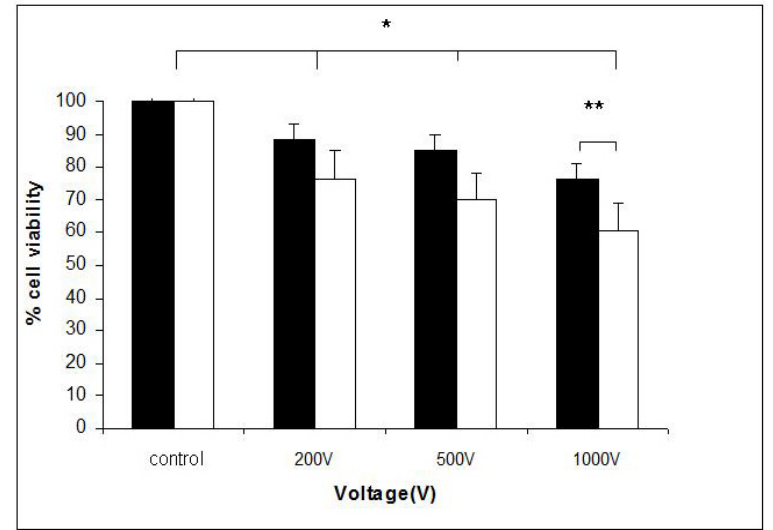
Figure 1. Viability of HaCaT keratinocytes after treatment with high voltage electric pulses alone (black columns) or in combination with rifampicin (white columns). Bars—SD (Standard Deviation); * p < 0.05 versus control groups; ** p < 0.01, significant difference between electroporated cells in the absence of rifampicin and electroporated cells in the presence of 20 μ g·mL − 1